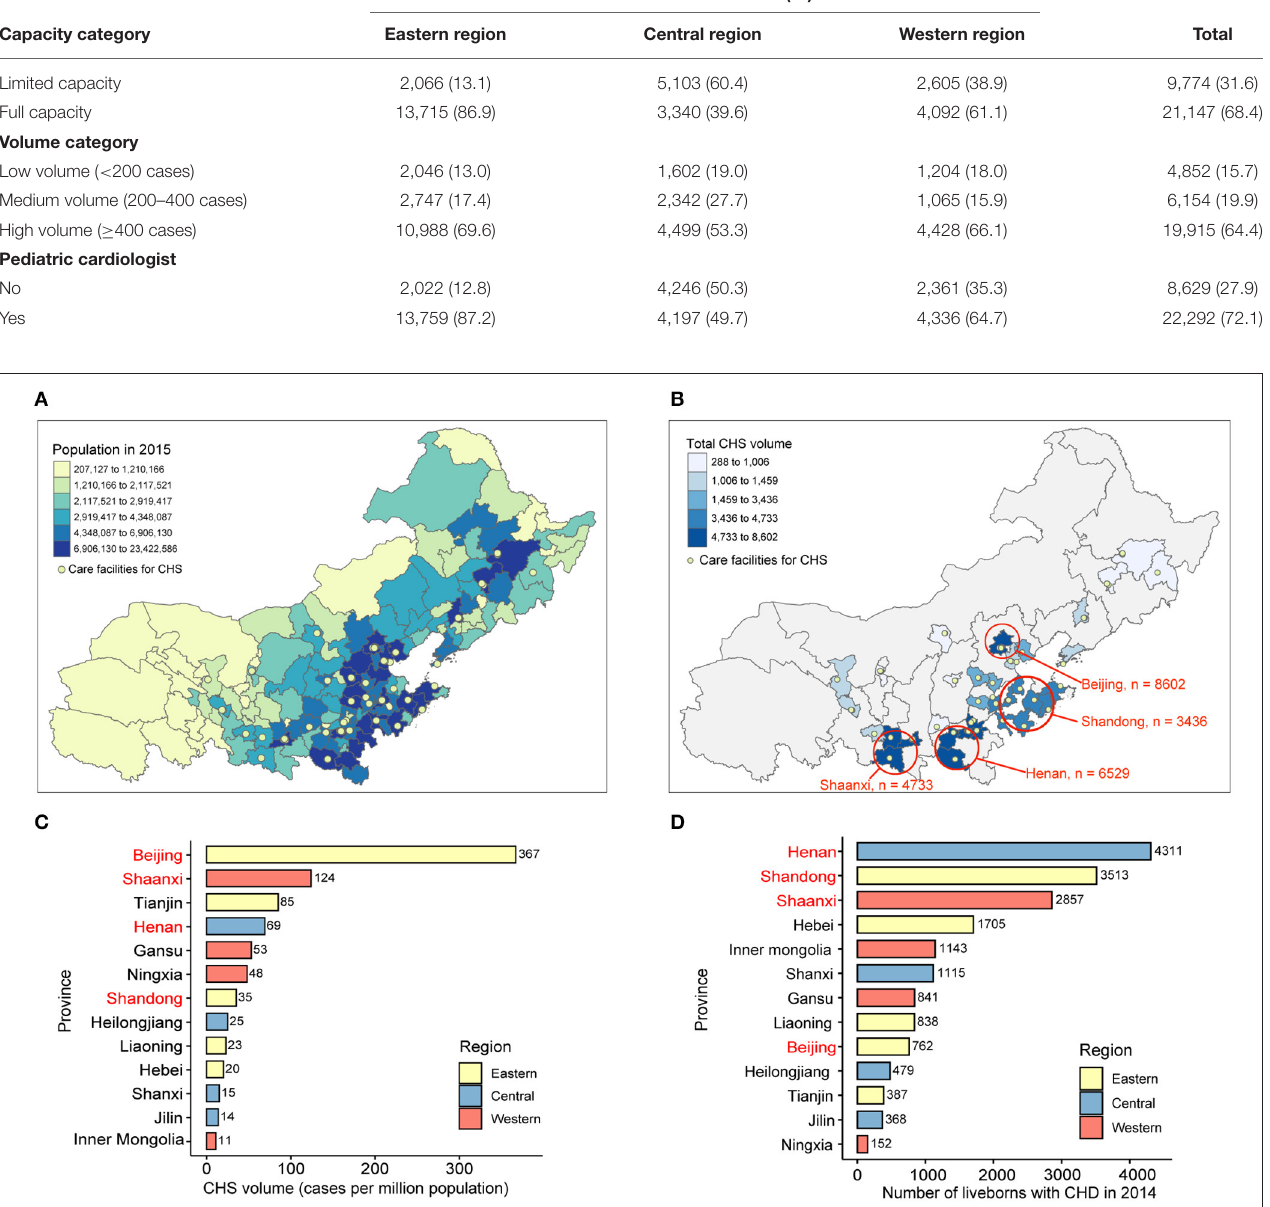
FIGURE 1 | Geographic distribution of CHS volume and CHD burden in northern China. (A) Geographic distribution of care facilities for CHS. Population data are shown in quantiles. (B) Regional distribution of total CHS volume in northern China. The results of top four provinces are displayed in the map. CHS volume data are shown in quantiles. (C) Average CHS volume in million population, as calculated by the total CHS volume divided by total population in 2015 in each province. (D) Newly diagnosed cases of CHD in live births by geographic regions in 2014. CHS, congenital heart surgery; CHD, congenital heart